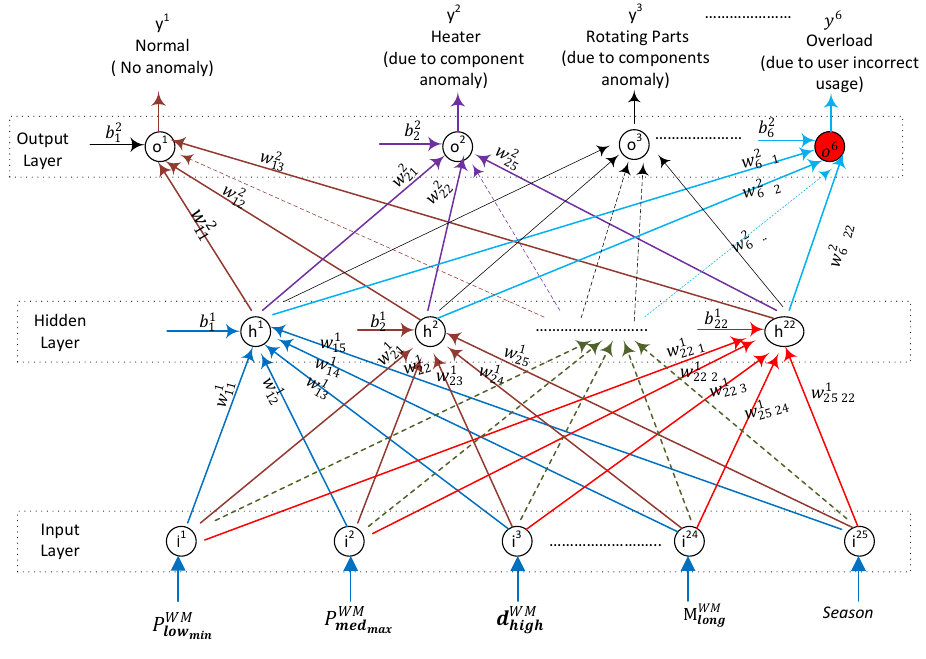
Figure 14. WM-ANN